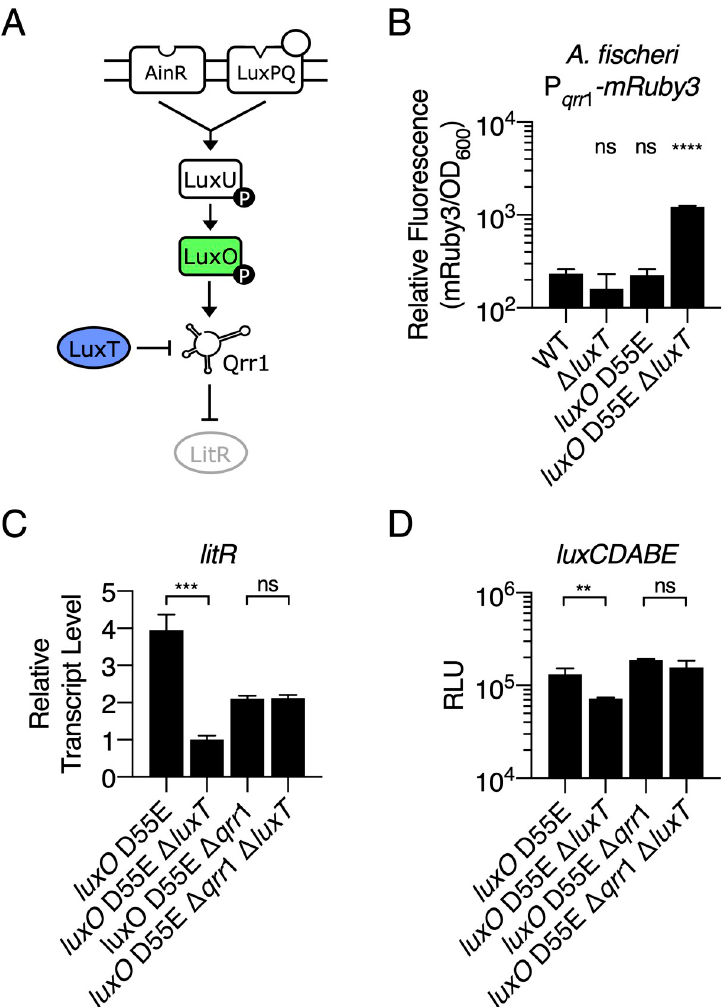
Fig 6. LuxT represses qrr 1 in A . fischeri . (A) Simplified A . fischeri QS pathway at LCD. See text for details. (B) Relative fluorescence values (mRuby3/OD 600 ) of the indicated A . fischeri strains carrying a P transcriptional reporter on a plasmid. Values represent relative fluorescence at OD 600 = 0.6 for each sample. (C) litR mRNA levels in the designated A . fischeri strains at OD 600 = 1 obtained by qRT-PCR. (D) Bioluminescence production of the indicated A . fischeri strains at OD 600 = 1. Relative light units (RLU) are counts/min mL -1 per OD 600 . For B, C, and D, error bars represent standard deviations of the means of n = 3 biological replicates, and unpaired two-tailed t tests with Welch’s correction were conducted comparing the WT to the mutants (B) or the two indicated samples (C and D). p -values: ns � 0.05, �� < 0.01, ��� < 0.001, ���� <